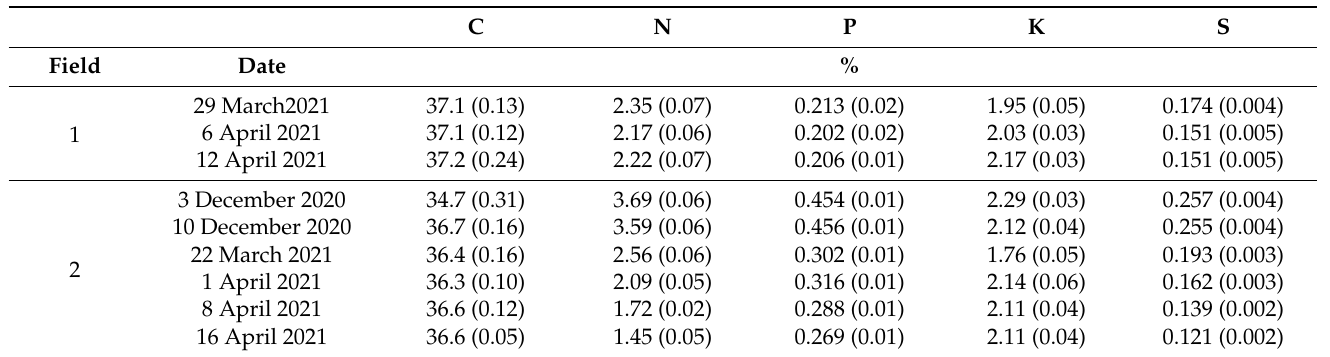
Table 5. Mean (standard error) of concentration-based in-field cereal rye nutrient data collected on the date of each UAV flight. C N P K